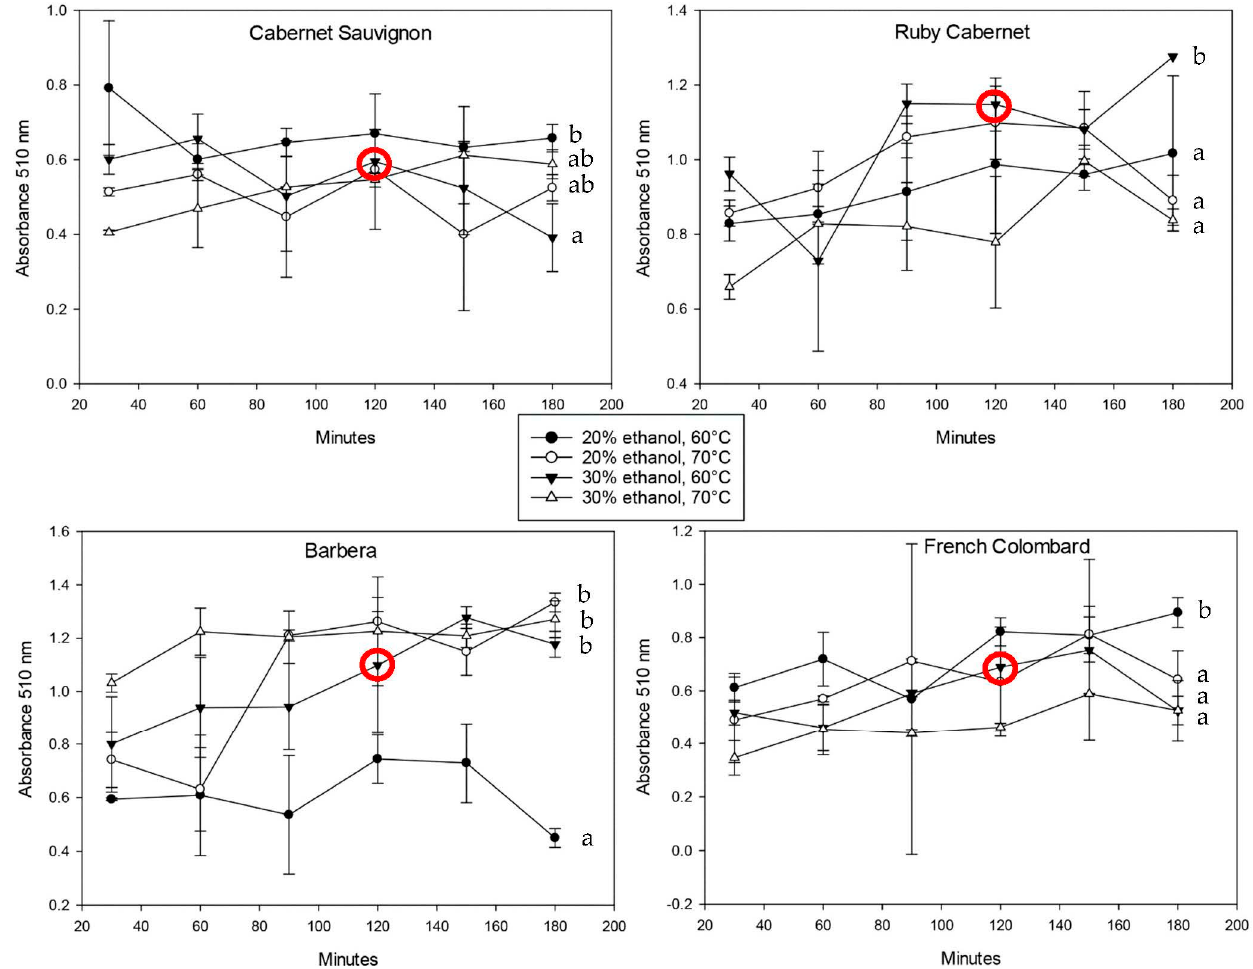
Figure 2. Spectrophotometric analysis of iron-reactive protein-precipitable phenolics in leaf tissue extracts over time. Extracts are shown for four cultivars using different temperature-solvent strength combinations. The red circle indicates the extraction conditions that were chosen for the proposed method. Statistically significant differences ( p < 0.05) within each dataset are indicated using letters a,